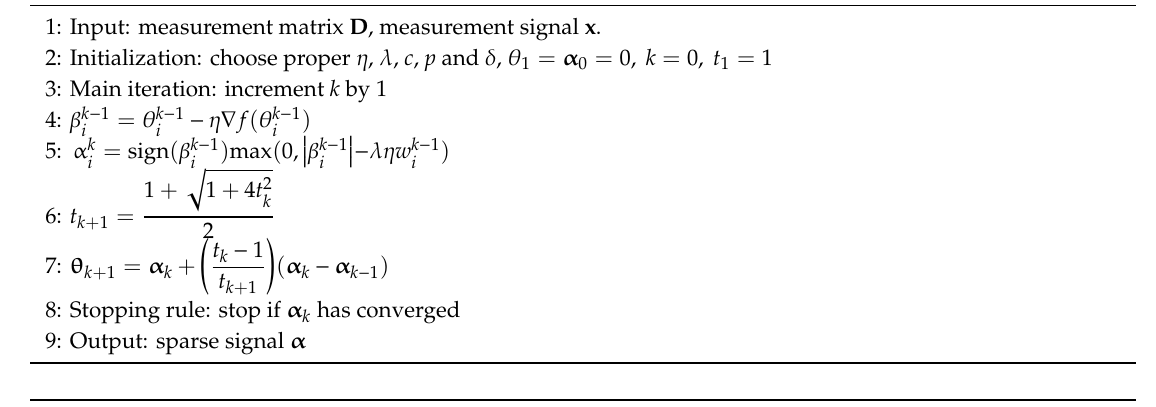
Algorithm 7 Fast Negentropy + (cid:96) 0.5 Norm